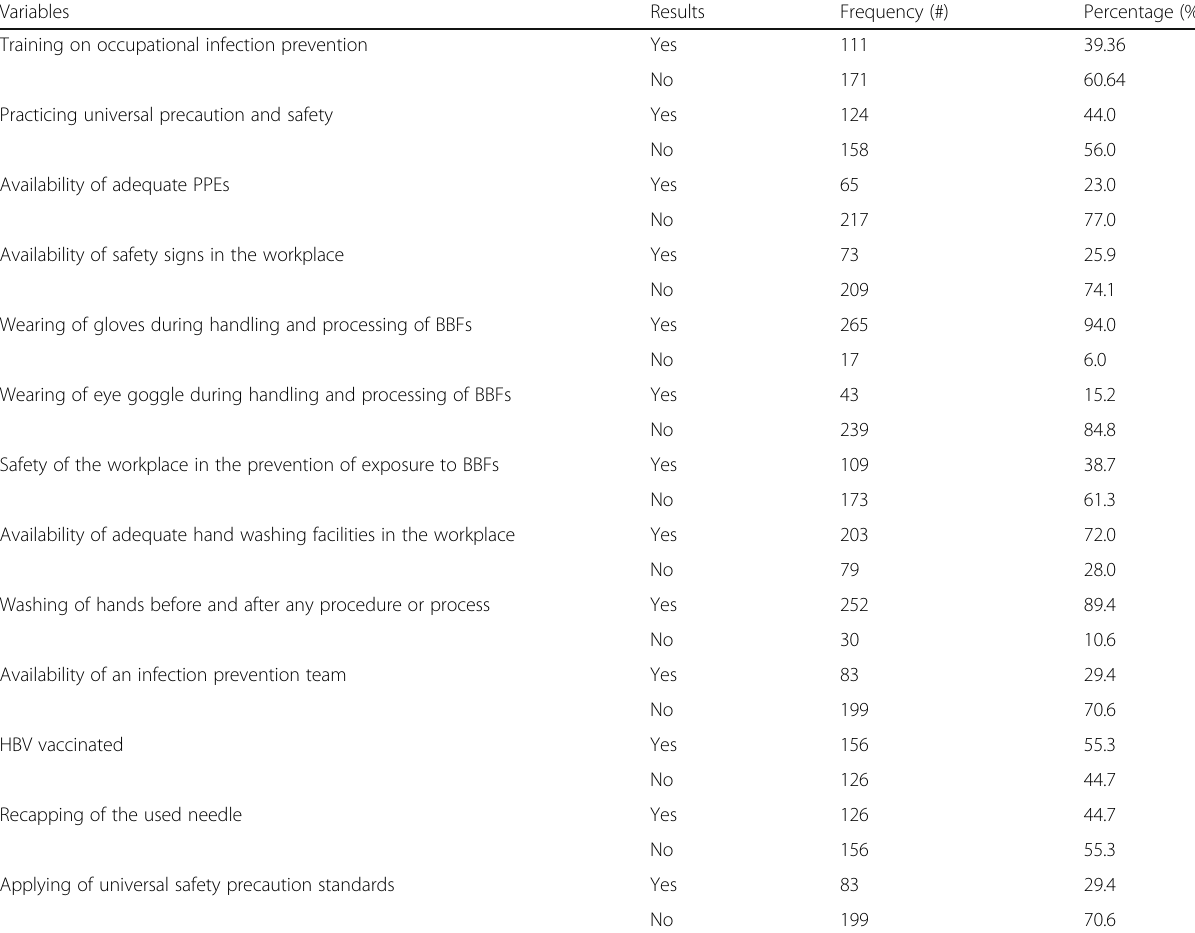
Table 3 Distribution of common factors to occupational exposures of blood and body fluids among health care workers